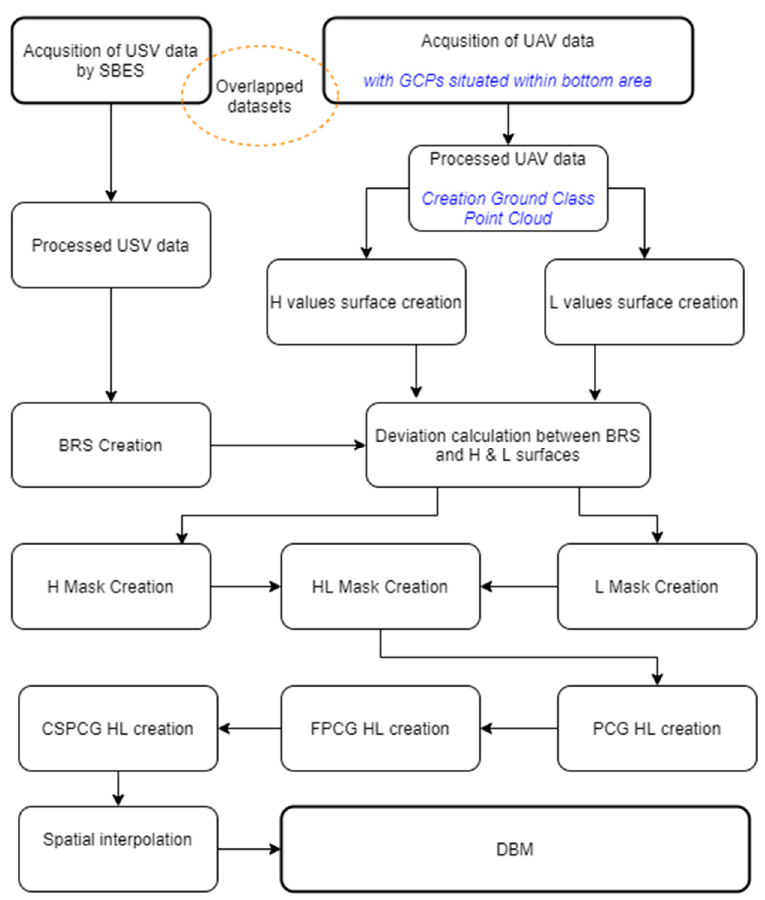
Figure 25. Proposed method for integrating USV and UAV data in terms of geoprocessing bathymetric and photogrammetric data.